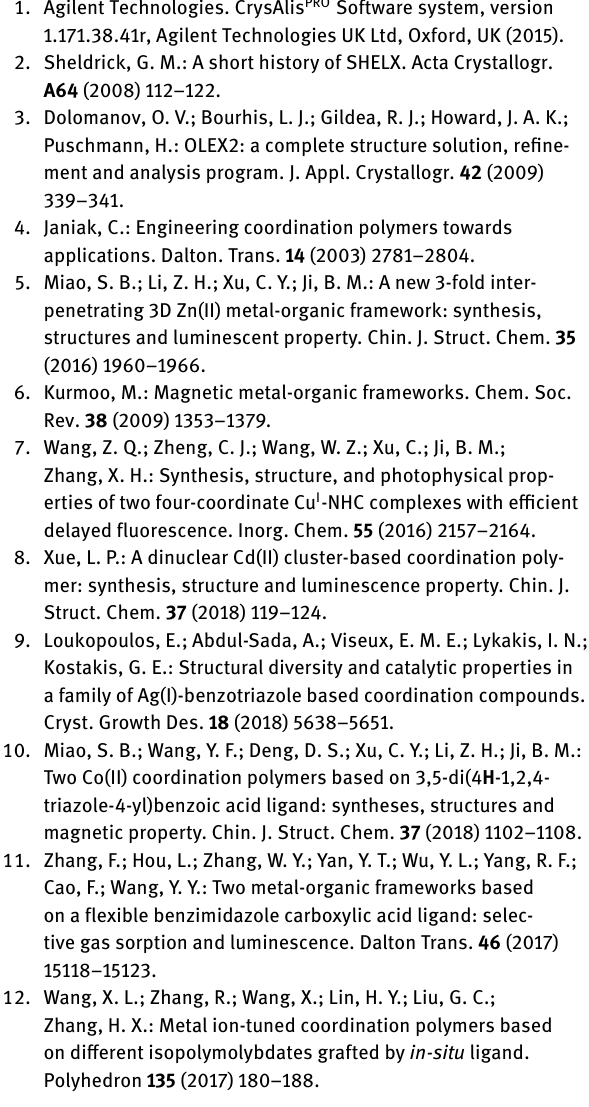
atoms from four different ligands. The Ag—N bond lengths are 2.257(2) and 2.273(2) Å, and the Ag—O bond lengths are 2.416(2) and 2.523(2) Å, respectively. The 2-(1,2,4-triazol-2) benzenecarboxylato ligand is deprotonated. The carboxyl group connect with two Ag(I) ions, the triazole also coordi- nate with two Ag(I) ions. By this mode, the organic ligands connect adjacent Ag(I) ions, give a 2D framework, as shown in the lower part of the